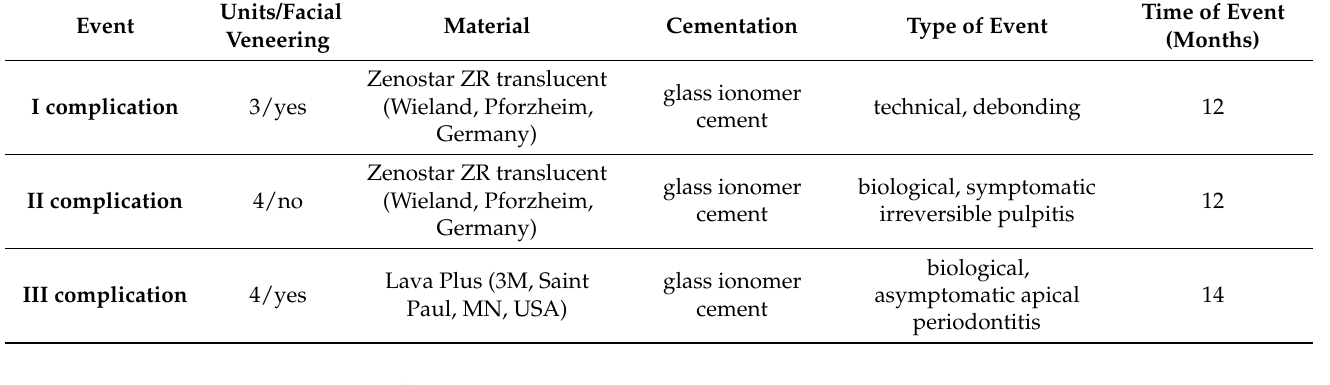
Table 2. Overview of the events.